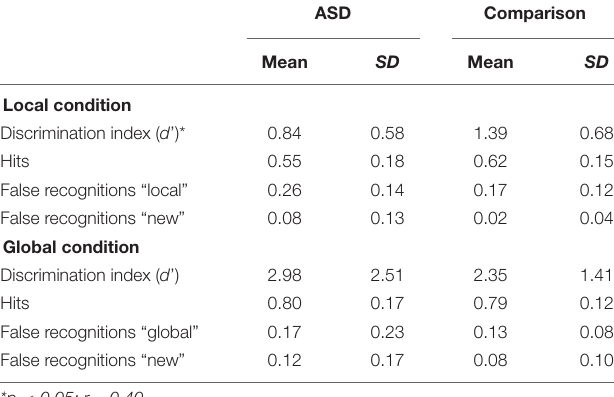
TABLE 2 | Performance at the recognition